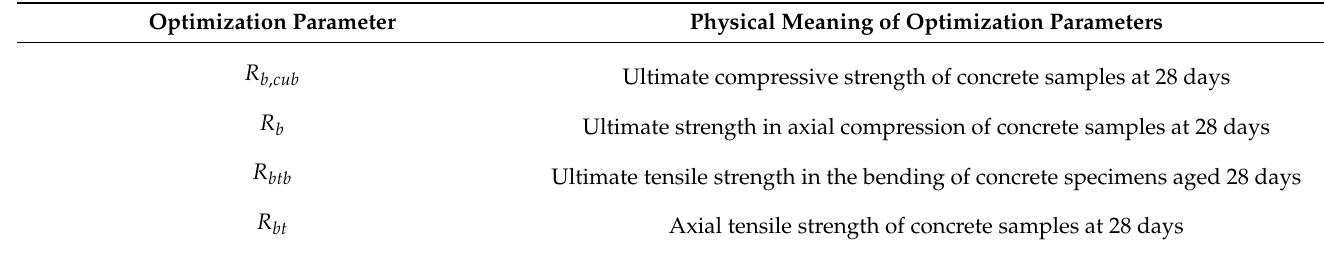
Table 7. Parametersforoptimizingthecompositionofthecomplexnano-modifierandtheirboundaryvalues. Optimization Parameter